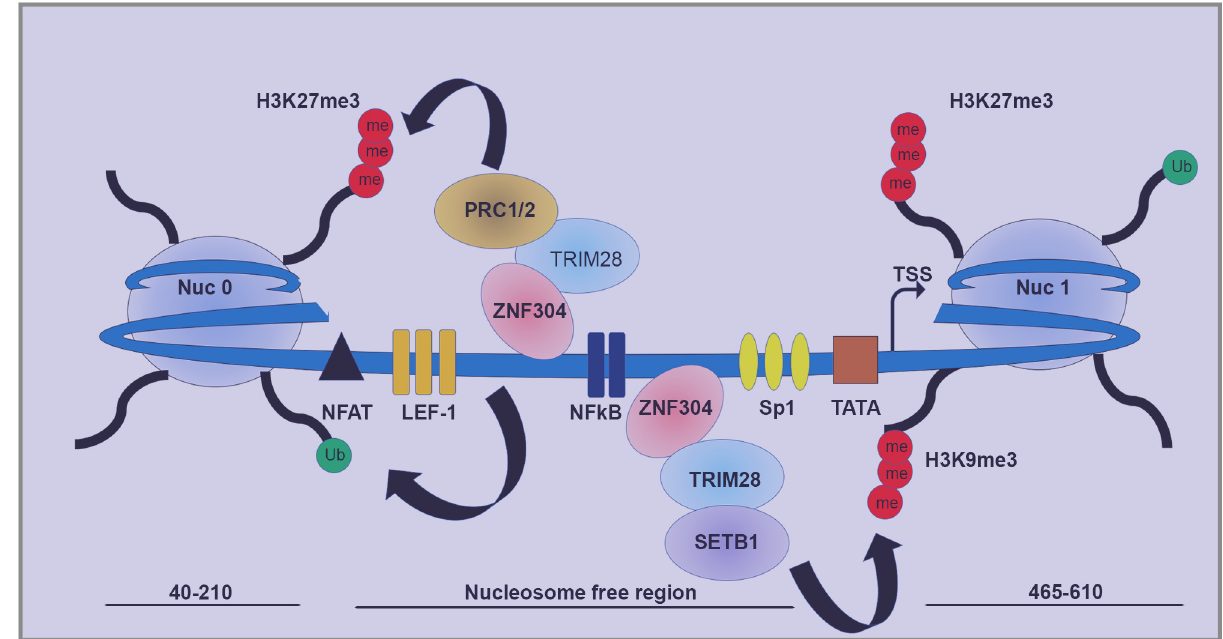
Fig 9. Model for the functional significance of ZNF304 for HIV latency. ZNF304 is tethered to the HIV promoter around NF κ B sites, while associating with TRIM28 and recruiting SETB1 and the PRC1/2 repressive complexes, which deposits the repressive histone marks H3K27me3, H3K9me3, and H2AK119ub to silence HIV gene